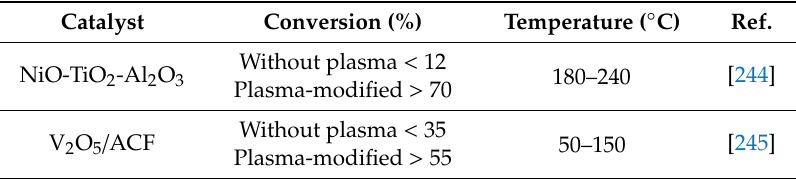
Table 6. The performance contrast of plasma-modified